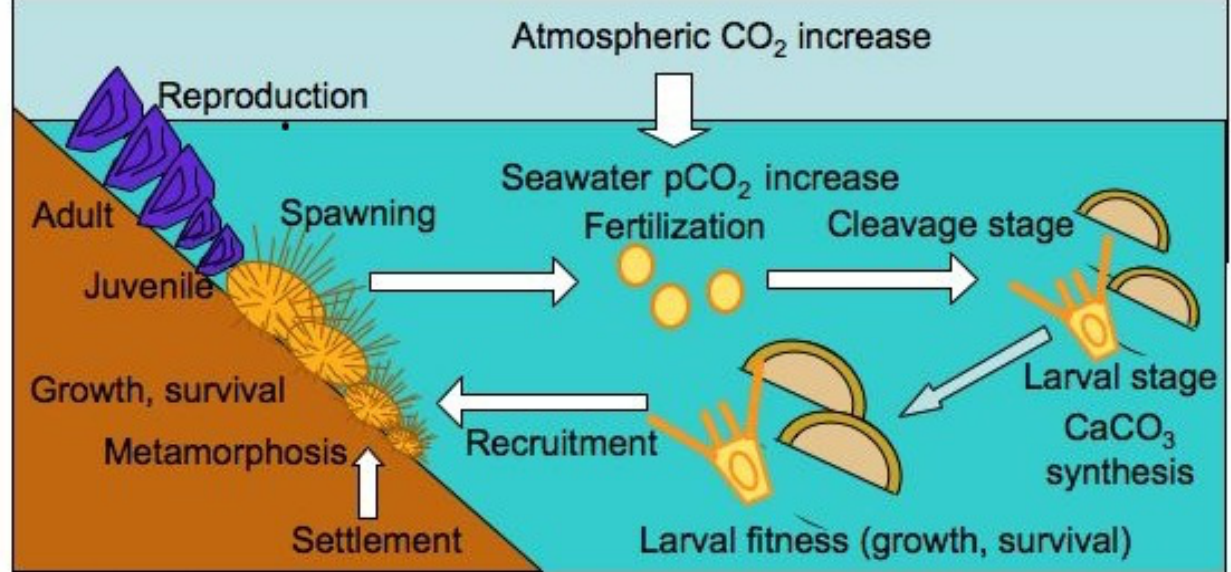
Figure 1. Life cycle stages of benthic broadcast spawners and impacts of ocean acidification on fertilisation and larval development [7].